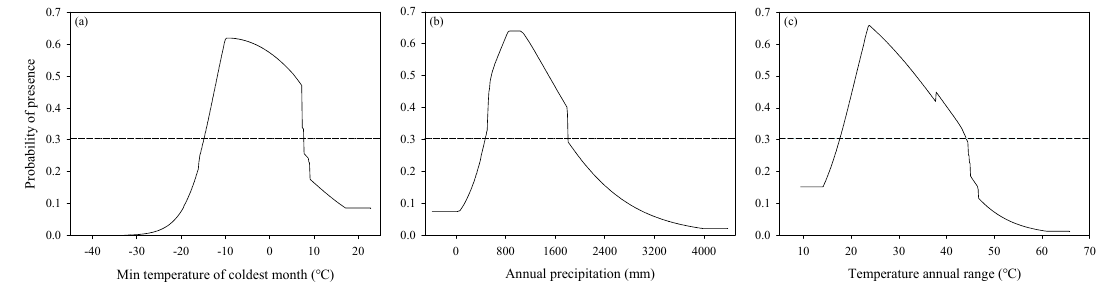
Figure 2. The response curves of three main variables contributing to the habitat suitability of Juglans regia . ( a ) Min temperature of the coldest month (°C); ( b ) annual precipitation (mm); ( c ) temperature annual range (°C). Dashed lines represent the threshold probability (0.31) indicative of species presence.